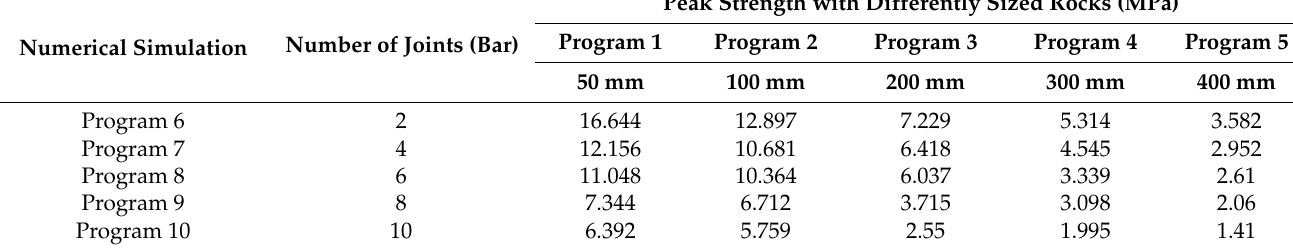
Table 8. Peak strength with differently sized